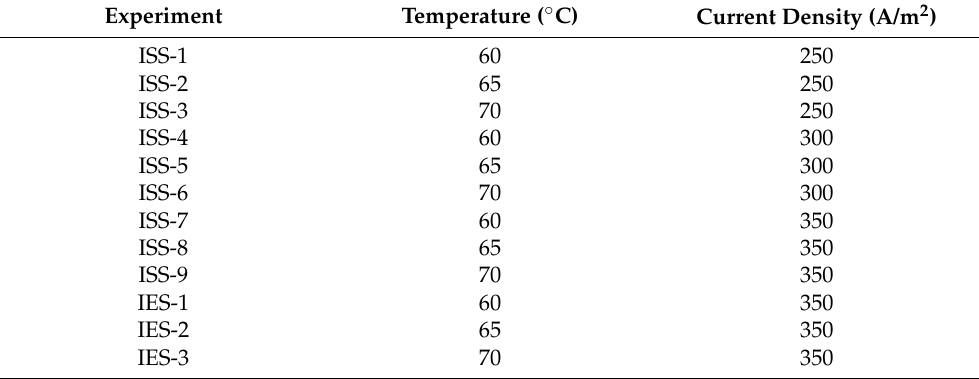
Table 3. Experimental series for electrolyte inclusion experiments. ISS-series was conducted with synthetic electrolytes and IES-series represents the experiments with industrial electrolytes.